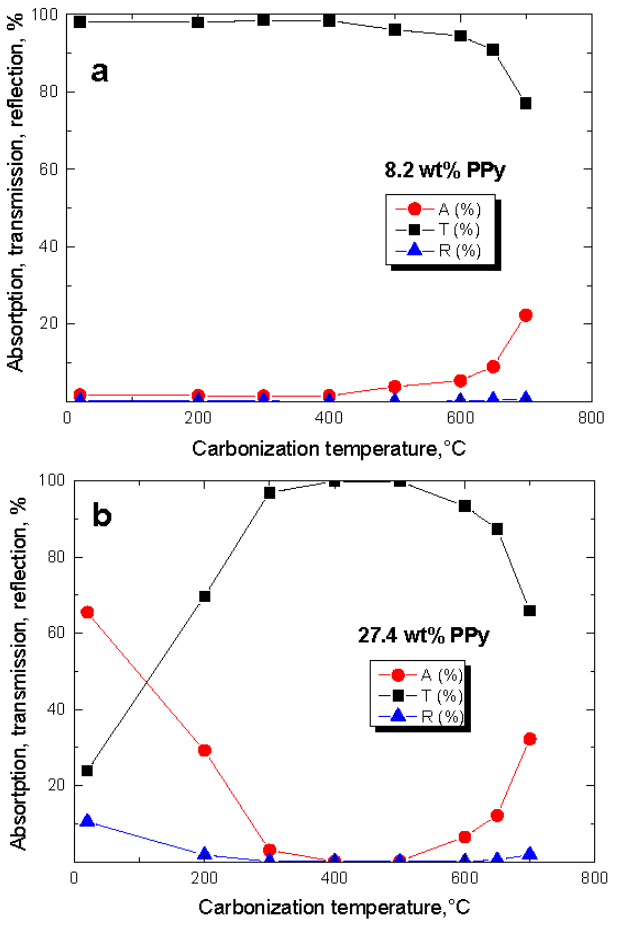
Figure 14. Absorption, transmission and reflection contributions of the 9 GHz radiation for the sponges containing ( a ) 8.2 wt%, or ( b ) 27.4 wt% polypyrrole. sponges containing ( a ) 8.2 wt%, or ( b ) 27.4 wt%